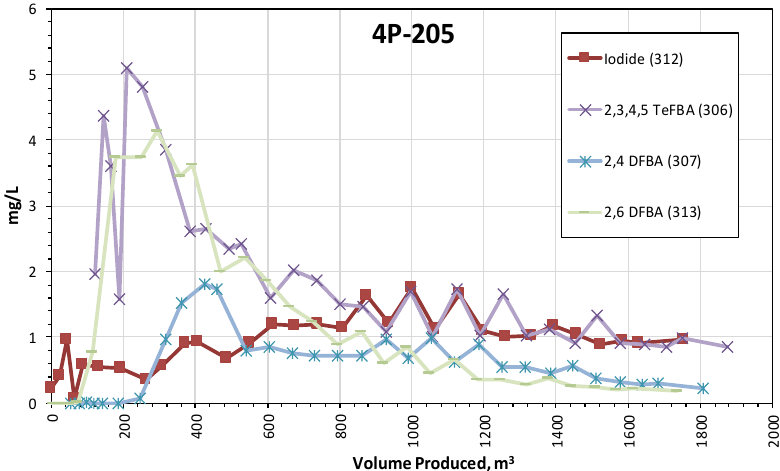
Figure A5. Tracer breakthrough curves as a function of volume produced in well 4P-205. Legend indicates number of the well into which each tracer was injected.